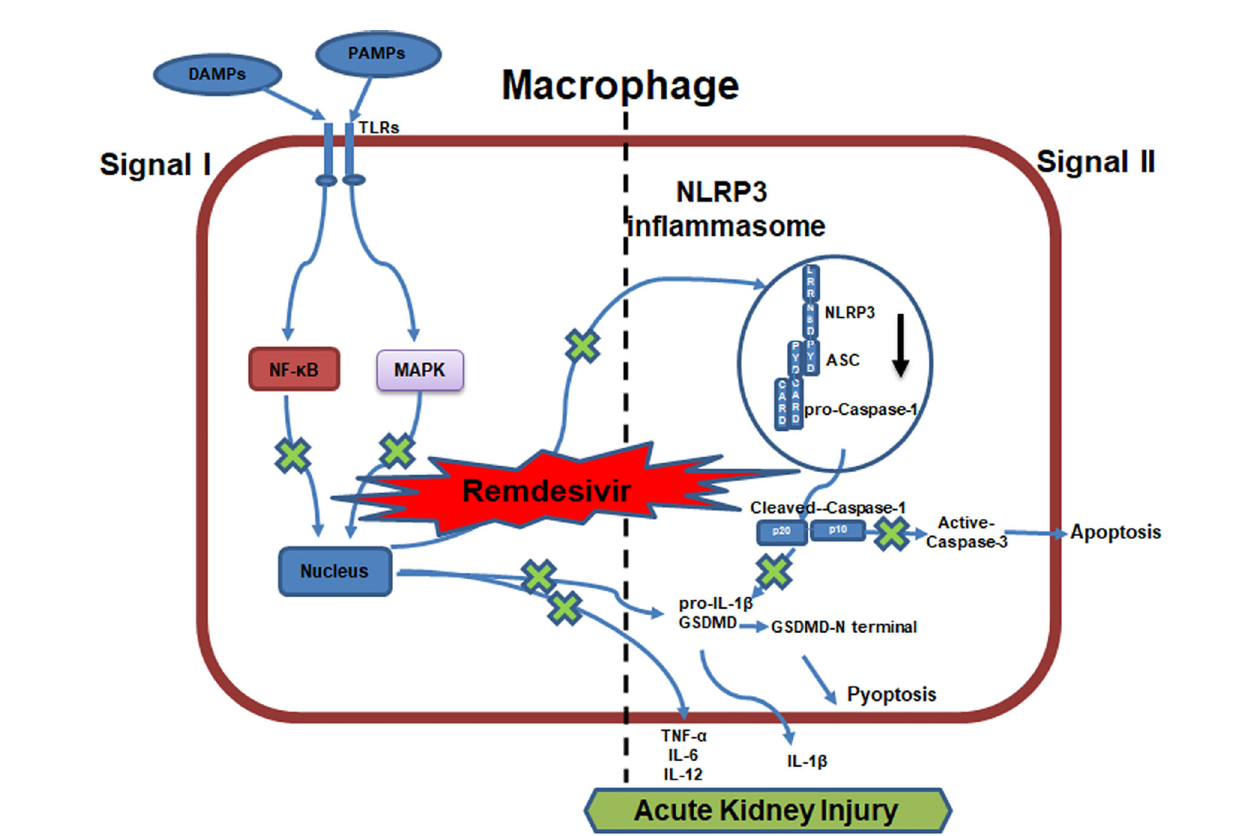
FIGURE 6 | Work model for RDV alleviates AKI by inhibiting NLRP3 in fl ammasome activation. RDV inhibits NF-kB and MAPK signaling activation, which reduces the transcription of NLRP3, IL-1 b , TNF- a , IL-6, IL-12, GSDMD inhibiting the NLRP3 in fl ammasome formation, apoptosis, pyroptosis and pro-in fl ammatory cytokine release and contributing to the alleviation of